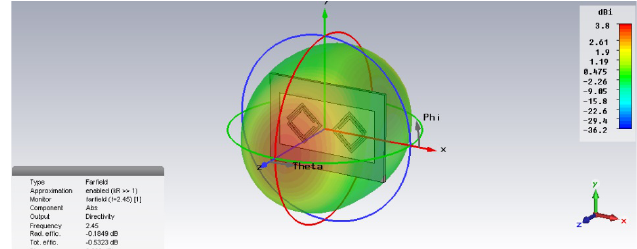
Figure 7: Simulated three-dimensional radiation pattern of the proposed slot antenna at 2.45 GHz.